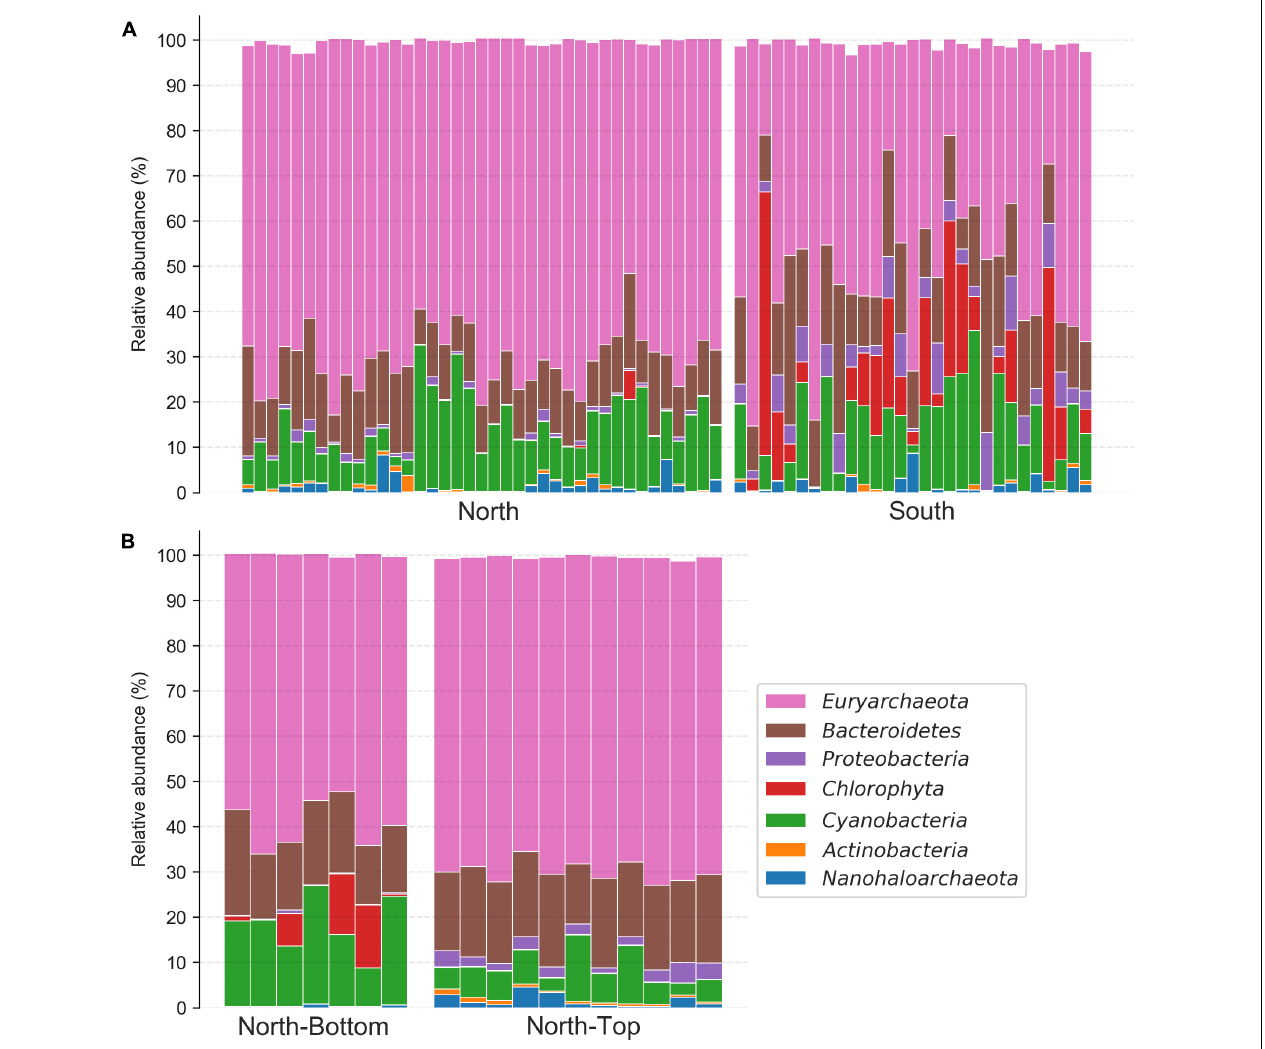
FIGURE 4 | Phylum-level taxonomy composition of halite communities from different locations. (A) North and South ends of the salar and (B) the top and bottom of the North hill. Relative abundances were estimated with the Qiime2 taxonomy assignment pipeline. Only the six most abundant phyla found in this community are